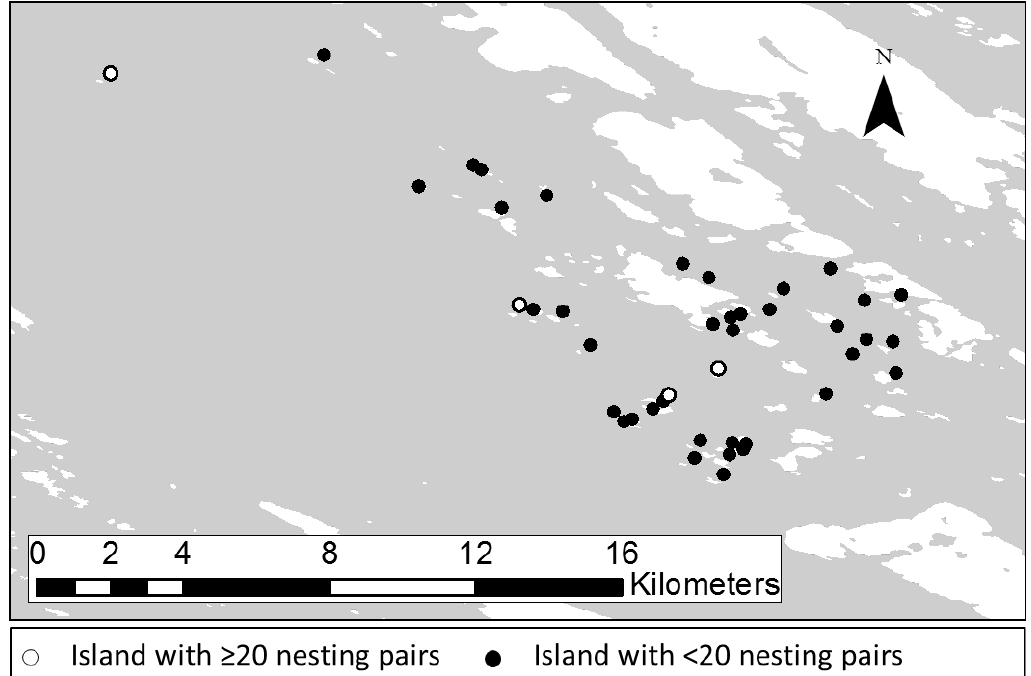
Figure A1.13. Survey zone 13: Southern Frobisher Bay, Frobisher